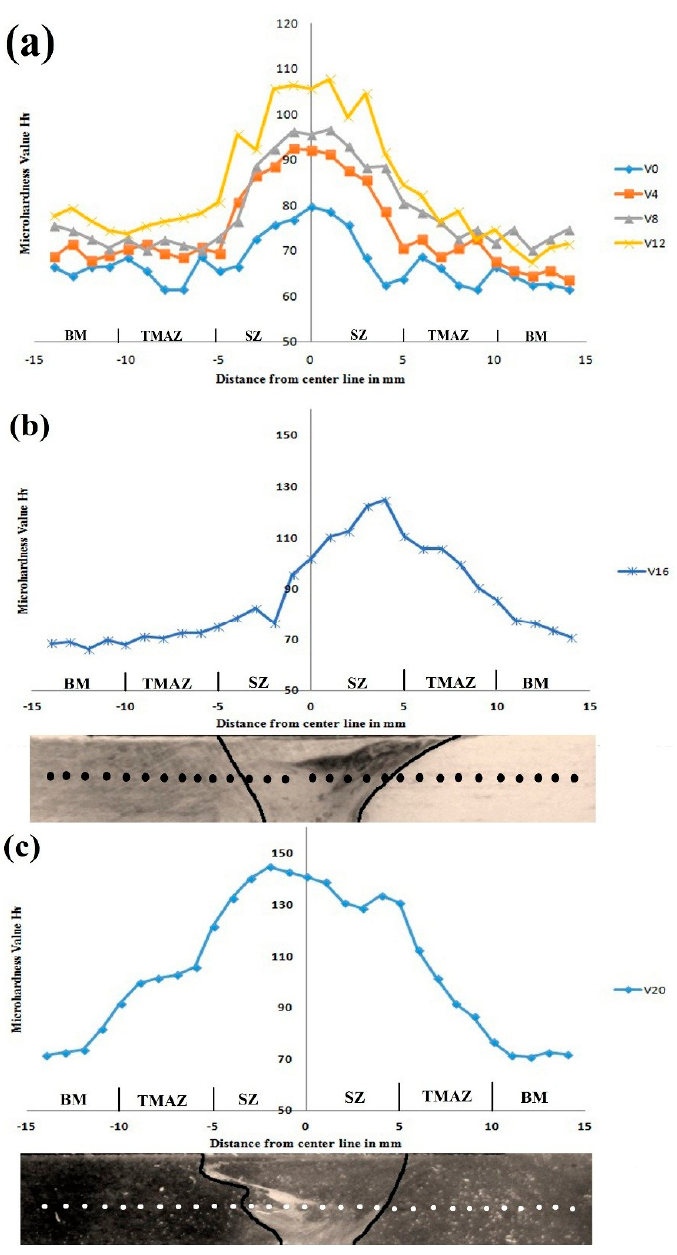
Figure 15. Microhardness distributions of AZ31B/SiC composite welded joints across the center line ( a ) V0 to V12 ( b ) V16 ( c )